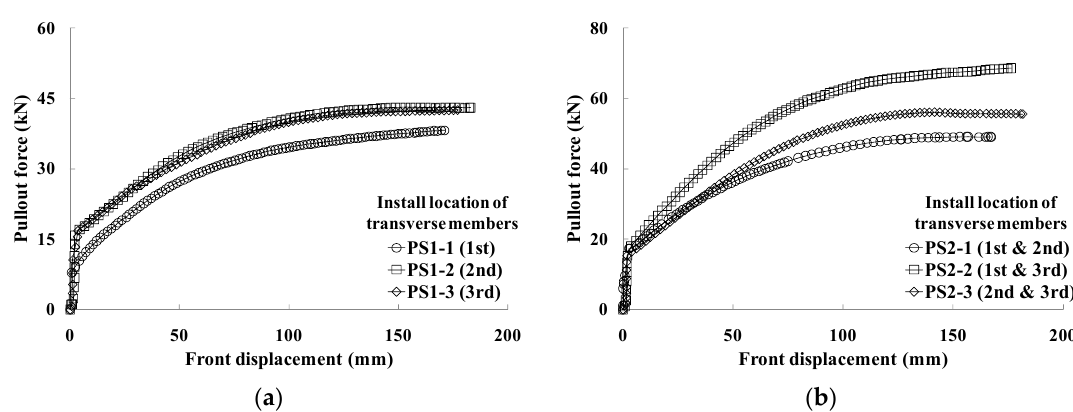
Figure 4. Results of pullout tests by change in installation location of transverse members (normal stress, 100 kPa): ( a ) number of transverse members—1 and ( b ) number of transverse members—2.